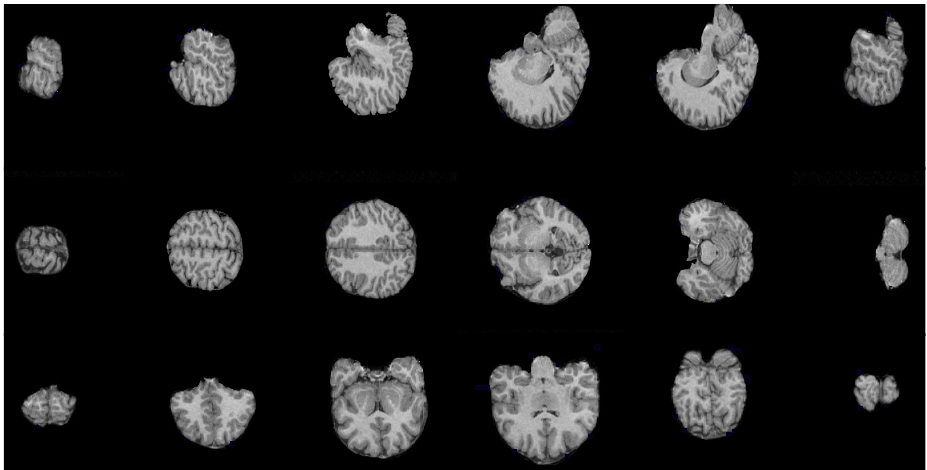
Figure 11. Brain slices in axial, sagittal, and coronal planes obtained by applying the hyperconnected viscous opening γ ∗ µ , with ε λ = 3 ( f ) v